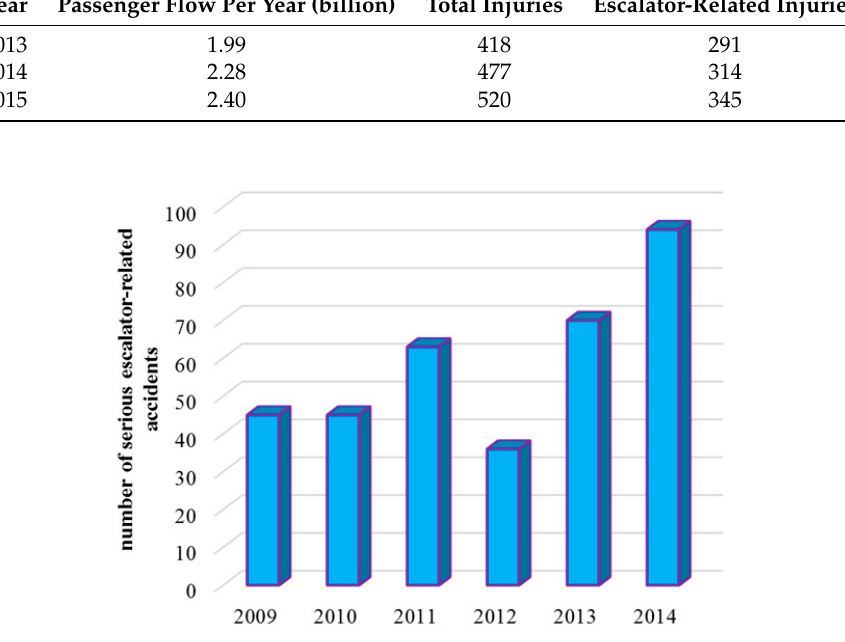
Figure 1. Trend of serious escalator-related accidents in China, 2009–2014 [1]. Reproduced with permission from [1], Elsevier,